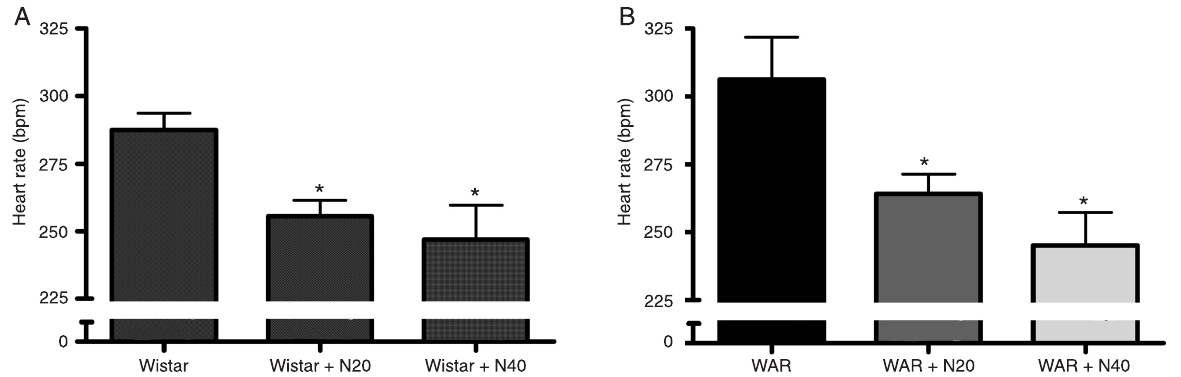
Figure 2. Effects of 20 and 40 mg/kg nifedipine (N20 and N40) on the heart rate of isolated hearts of A , Wistar rats and B , Wistar au- diogenic rats (WAR). Data are reported as means ± SEM for 6 rats per group. *P < 0.05 compared to control (Wistar or WAR) (one-way ANOVA followed by the Newman-Keuls